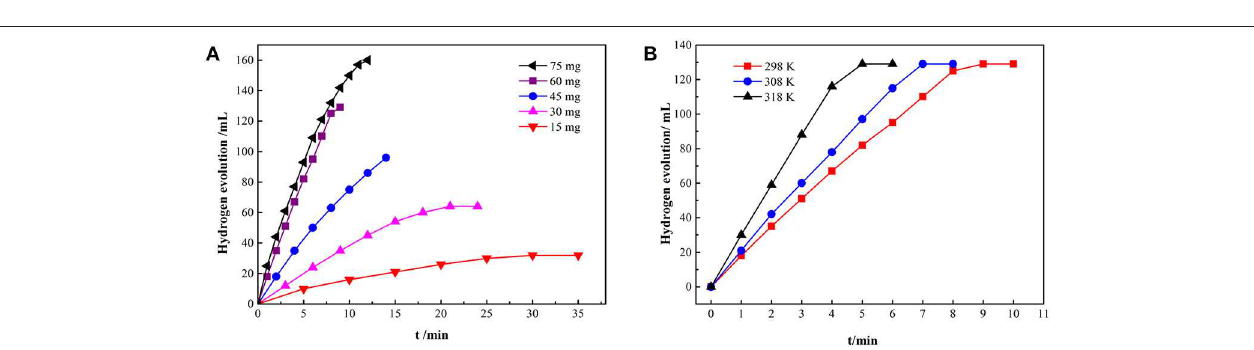
FIGURE 6 | The volume of hydrogen for the Ru/PAF-72 catalytic hydrolysis of AB with different concentrations of AB (A) and at different temperature (B) .